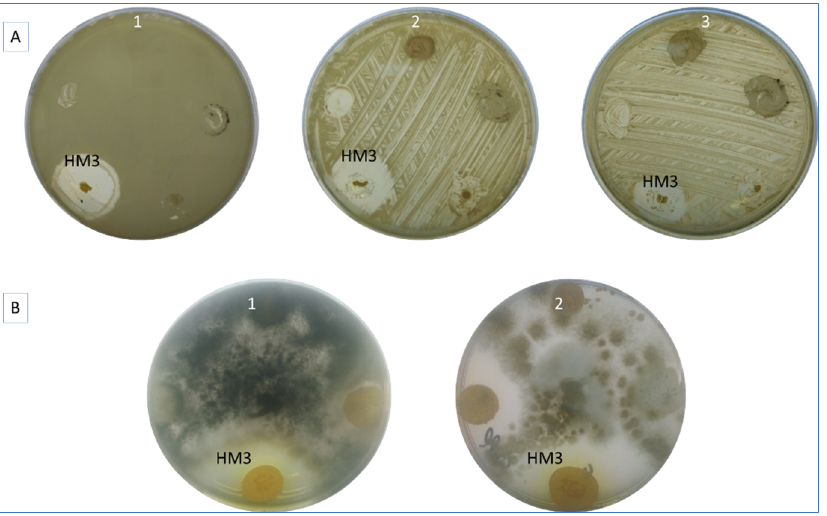
Figure 1. Antibacterial and antifungal activities of S. thinghirensis HM3 ( A ) against three animal pathogenic and Gram-positive bacteria; (1) S. pneumoniae ATCC 49619, (2) S. aureus ATCC 29213, (3) MRSA-A. ( B ) against soil-borne disease fungi; (1) Thielaviopsis basicola, (2) Colletotrichum gloeosporides.